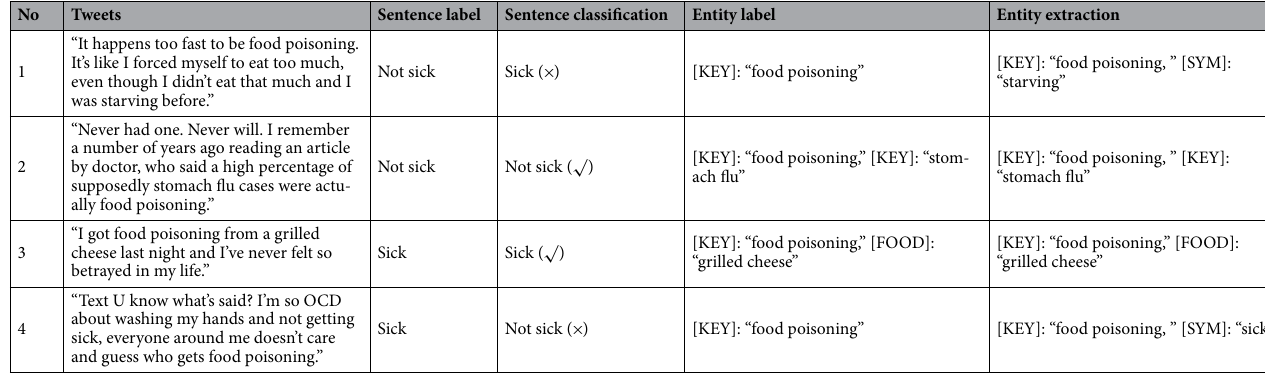
Table S5, in which the name of the models and their performance in predicting Twitter data using F1-scores are listed. These models were used as baseline models for comparing with our BERTweet model. In the individual models that only classify foodborne illness incidences, the F1-scores of the Foodborne Chicago model and of the FoodSafety SLT model were not provided in their reports, while the F1-score of the FINDER model was 0.74. The dual-task model developed by Effland et al. 17 was recognized as the one with best performance in the task of classifying unreported foodborne illness incidents from social media. In contrast with our study, the dataset they used was Yelp reviews instead of Twitter posts. The F1-score for the task of classifying “sick” reviews was 0.87 as indicated in their paper. By deploying the FoodborneNYC model released on Github.com to analyze tweets, we found that the F1-score dropped to 0.84, which could be attributed to the differences in the two datasets. The F1-score of our dual-task BERTweet model is 0.87, meaning that, in the task of classifying unreported foodborne illness incidences from Twitter data, our model outperforms the previous models. In addition, this model also can extract entities of importance to conduct outbreak analysis. The FoodborneNYC is also a dual-task model that can classify if a review contains “multiple” illnesses, which might be indicative of a potential outbreak from one restaurant. However, large-scale outbreaks such as multistate outbreaks are not occurring in one restaurant.